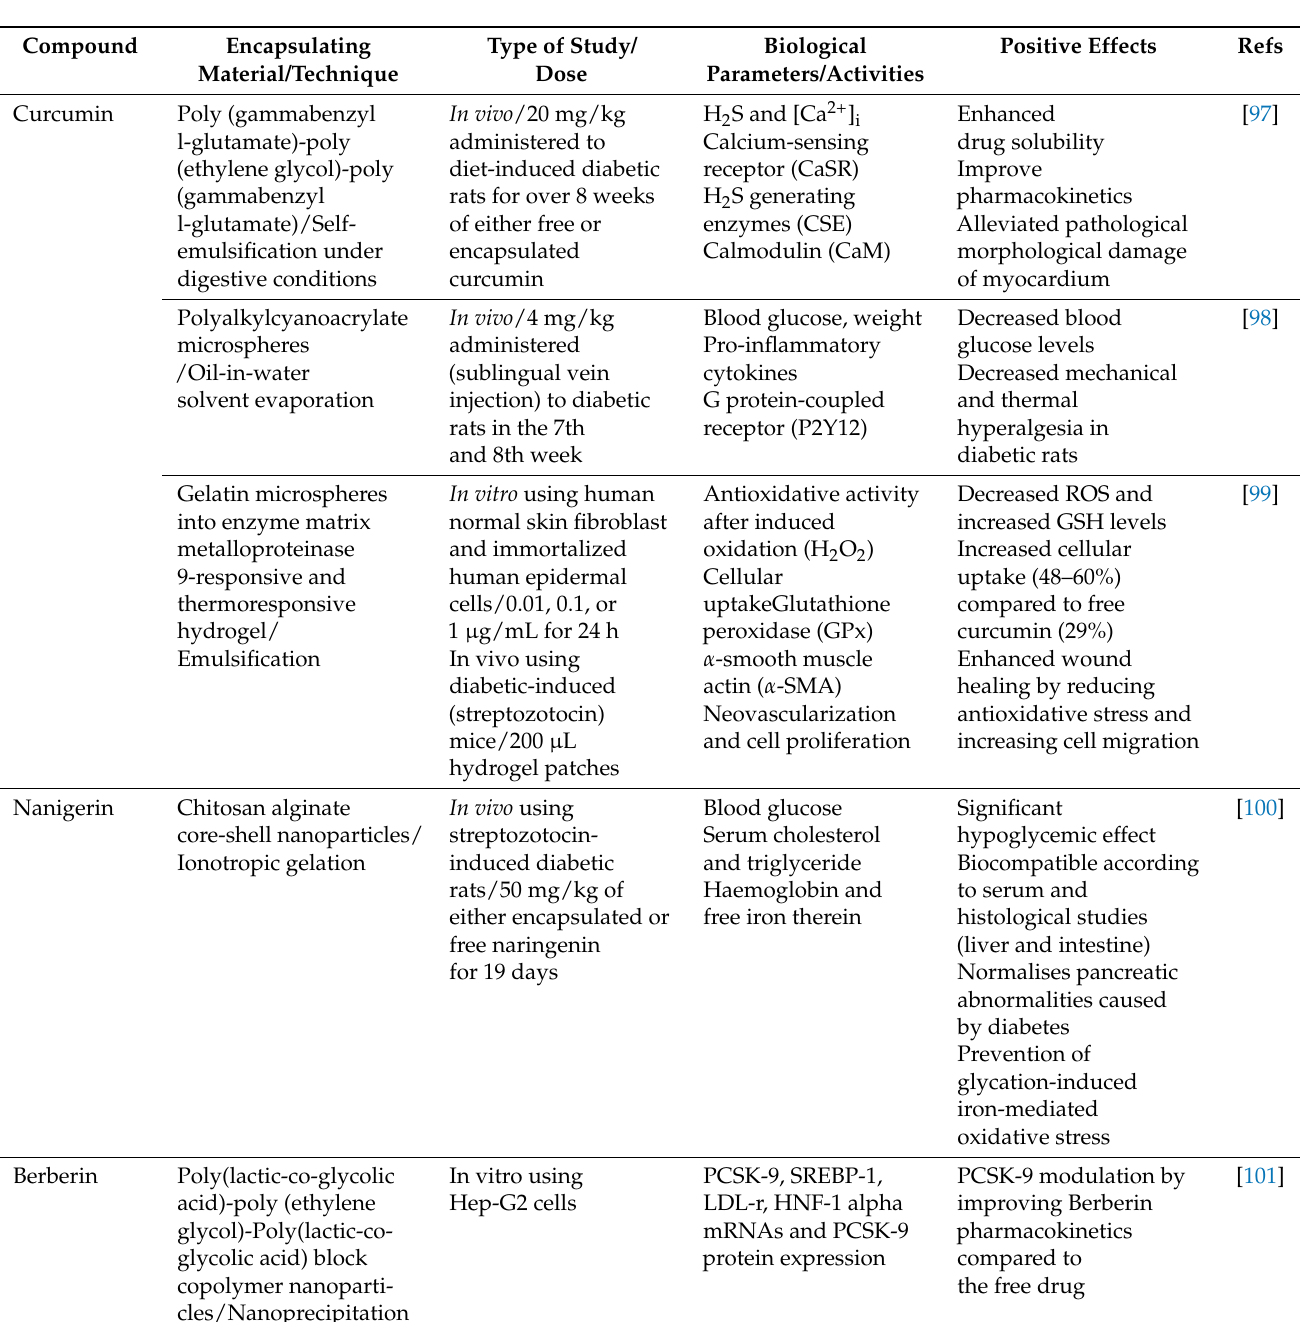
Table 2. Encapsulation technologies for different phenolic compounds and their positive effects observed in in vitro / in vivo